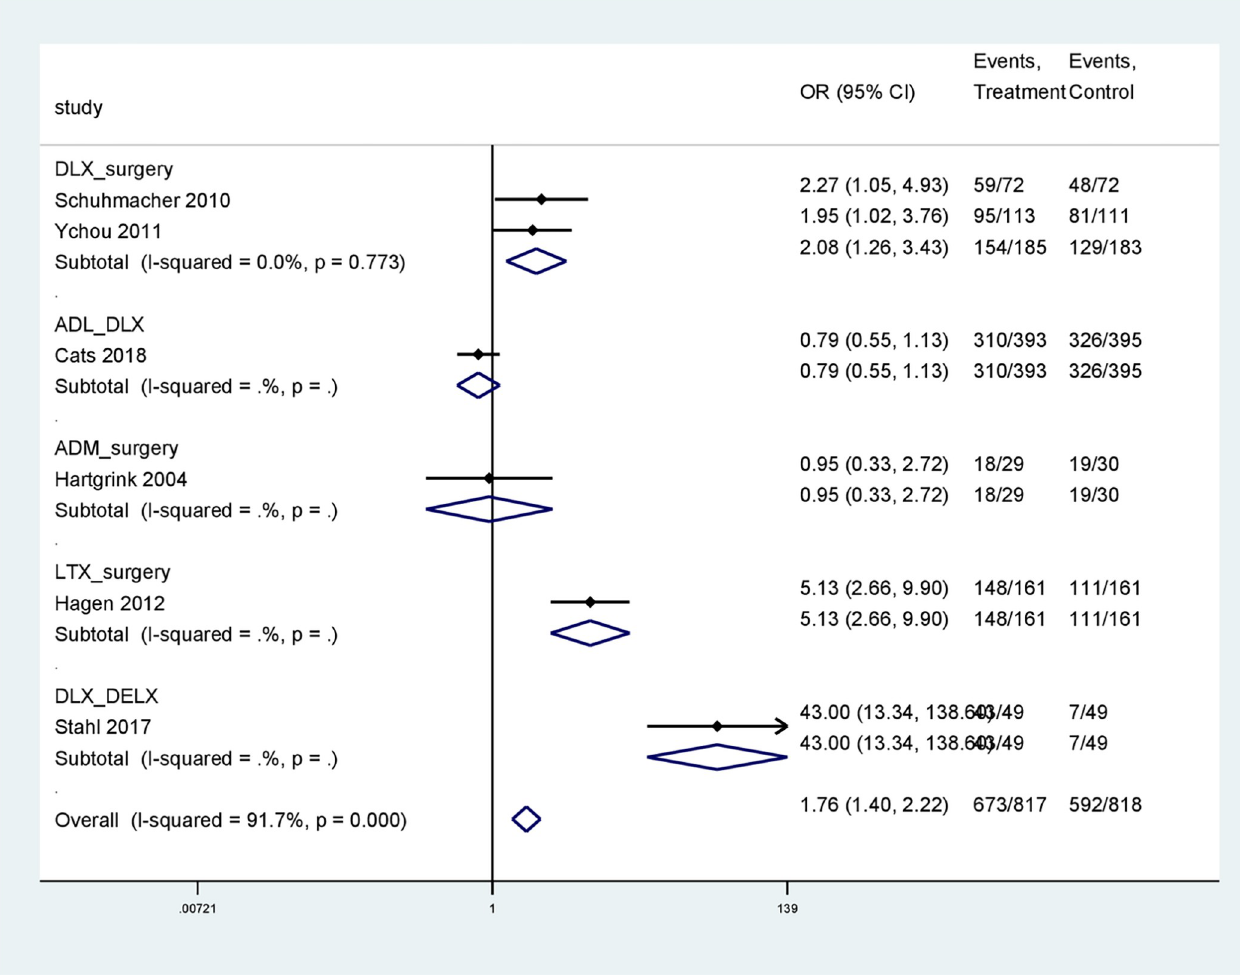
Fig 2. Pairwise meta-analysis for the Ro resection